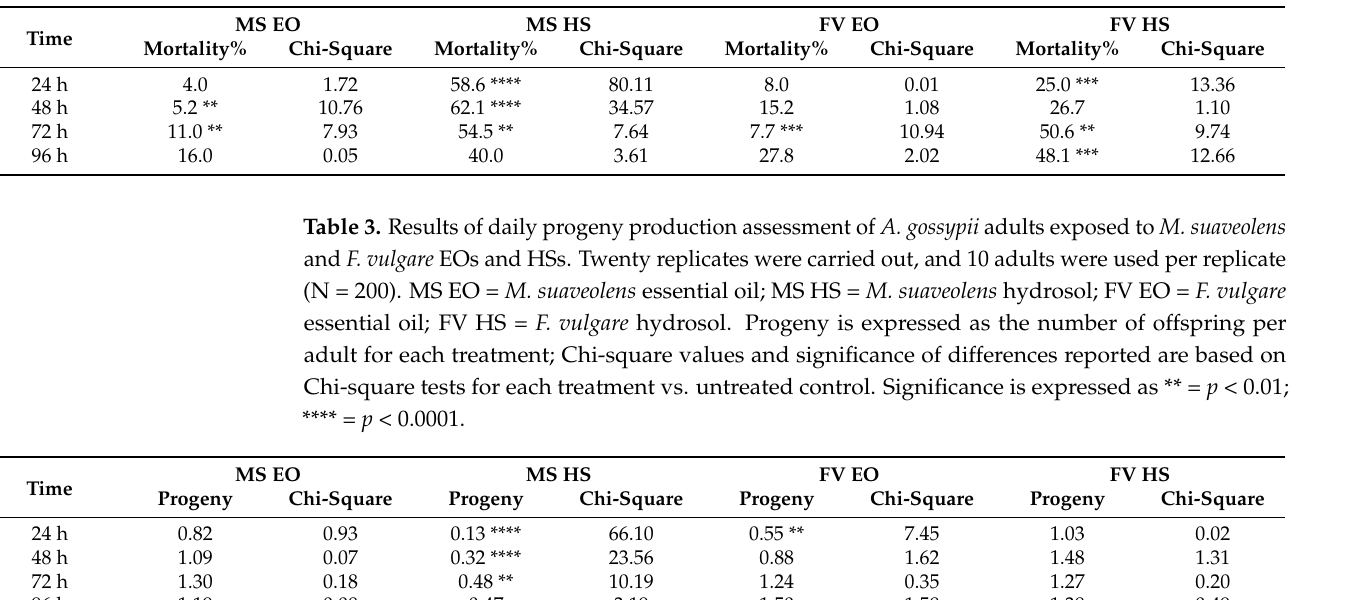
Table 2. Results of toxicity assay on M. suaveolens and F. vulgare essential oils and hydrosols against A. gossypii adults. Twenty replicates were carried out, and 10 adults were used per replicate (N = 200). MS EO = M. suaveolens essential oil; MS HS = M. suaveolens hydrosol; FV EO = F. vulgare essential oil; FV HS = F. vulgare hydrosol. Toxicity is expressed as adult mortality percentage for each treatment; Chi- square values and significance of differences reported are based on Chi-square tests for each treatment vs. untreated control. Significance is expressed as ** = p < 0.01; *** = p < 0.001; **** = p < 0.0001.